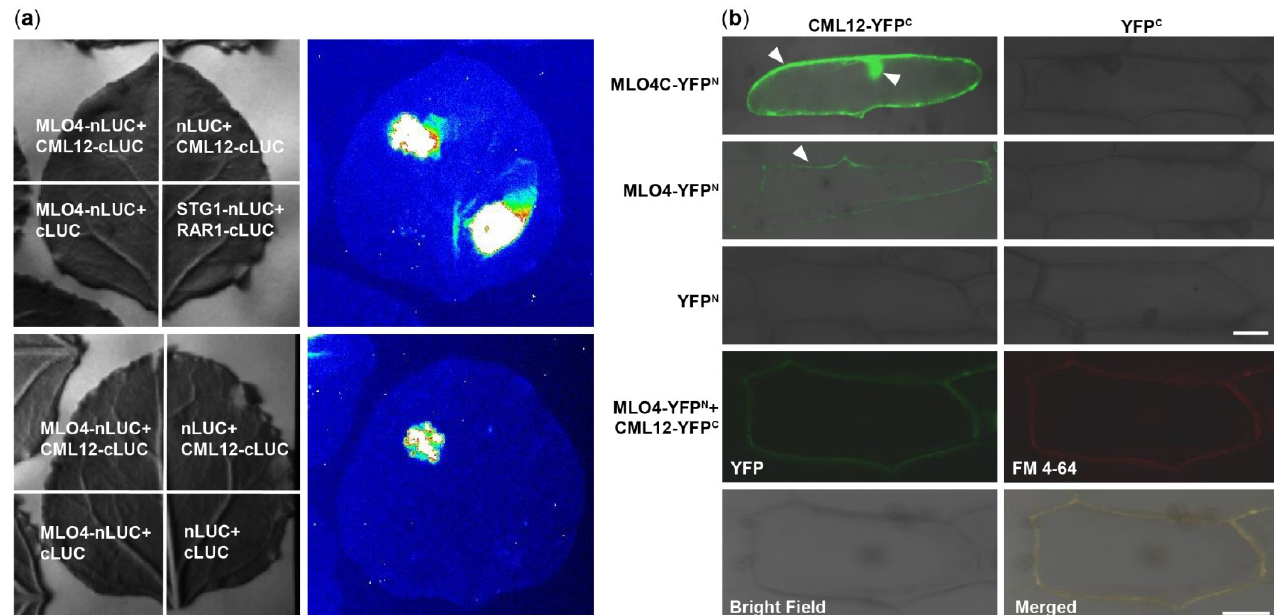
Figure 2. CML12 interacted with MLO4. ( a ) LCI results showed CML12 interacted with full length of MLO4 in tobacco cells. ( b ) BiFC results showed that CML12 interacted with cytoplasmic domain of MLO4 in onion cells, and the signal was detected in nucleus and periphery. When CML12 interacted with full length of MLO4, the signal was only detected on the plasma membrane, colocalized with FM 4-64. The YFP signals are indicated by pointed triangles in each figure. Bars = 50 μ m.